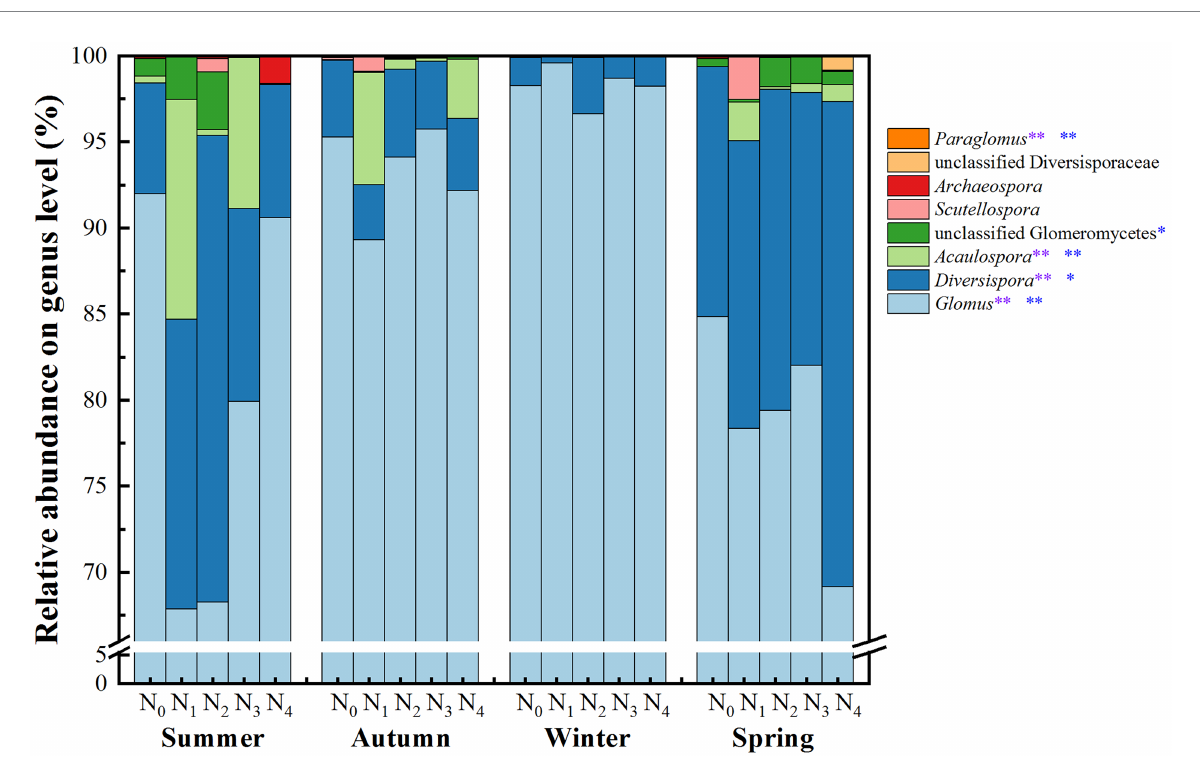
FIGURE 3 Average relative abundances of the AM fungal groups at the genus level in the poplar plantations under different nitrogen additions and seasons. N 0 , N 1 , N 2 , N 3 , and N 4 were 0, 5, 10, 15, and 30 gN·m − 2 ·a − 1 , respectively. The values are the means of three replicates. Two-way ANOVA outputs are shown in the figure: the purple * and ** indicate significant differences among different seasons at the 0.05 and 0.01 levels, respectively, and the blue * and ** indicate significant differences among nitrogen additions at the 0.05 and 0.01 levels,